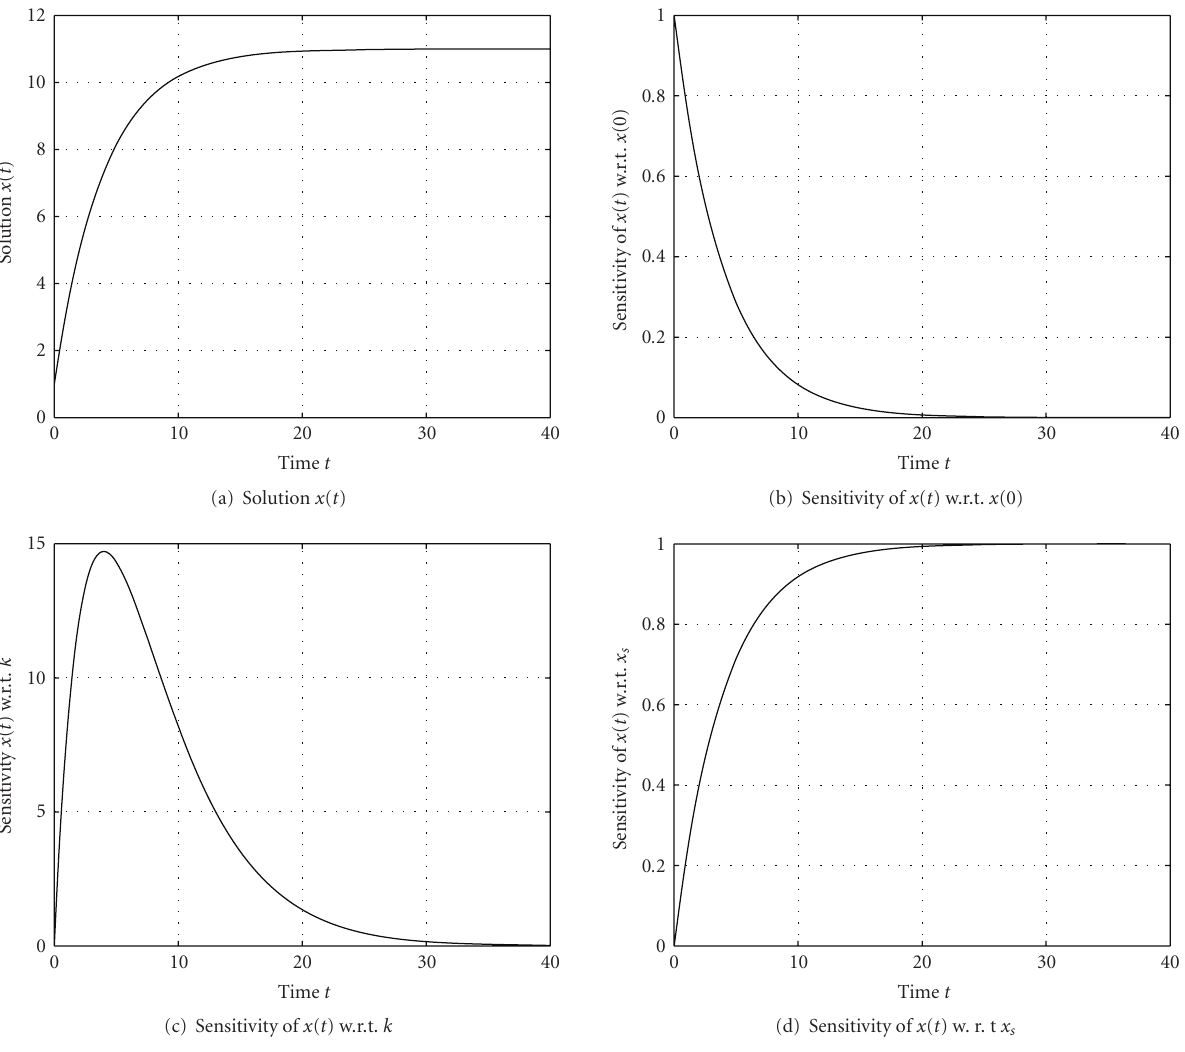
Figure 1: Evolution of the solution of x ( t ) and its sensitivities to c = ( x (0), x s , k ) = (1 . 0,11 . 0,0 . 25).